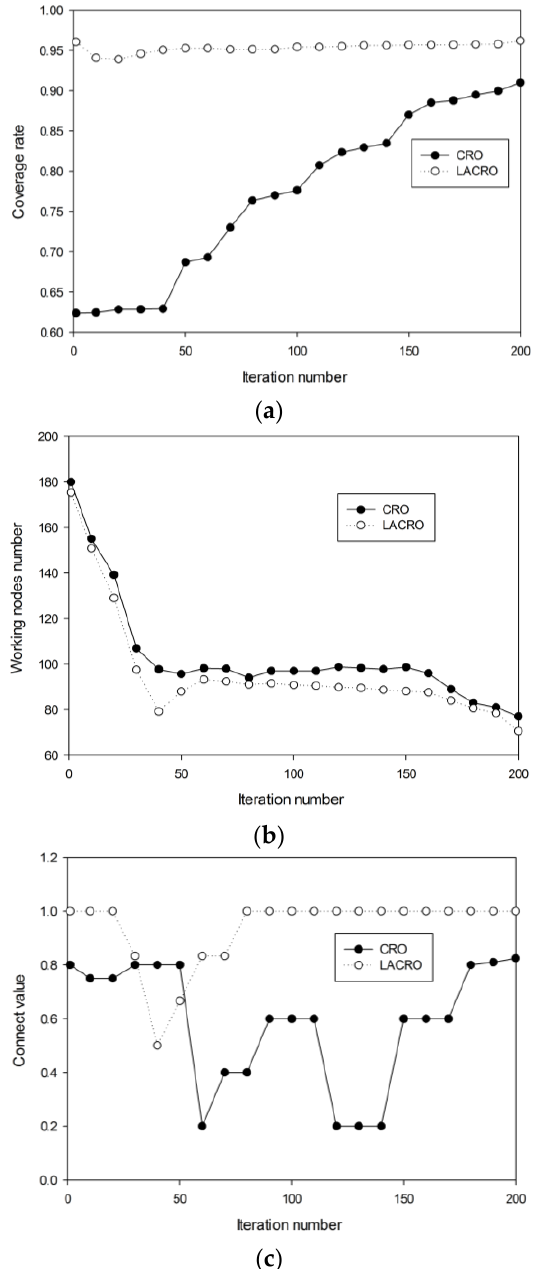
Figure 6. ( a ) Coverage rate f 1 in various generations; ( b ) Ratio of working nodes f 2 in various generations; ( c ) Connect value f 3 in various